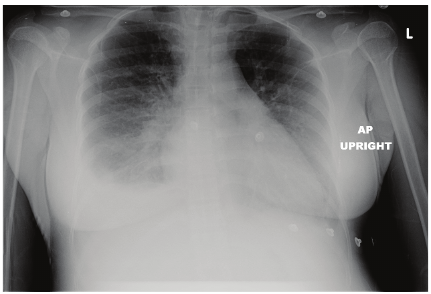
Figure 1: Chest X-ray showing bilateral pleural effusion and pulmonary congestion on admission.